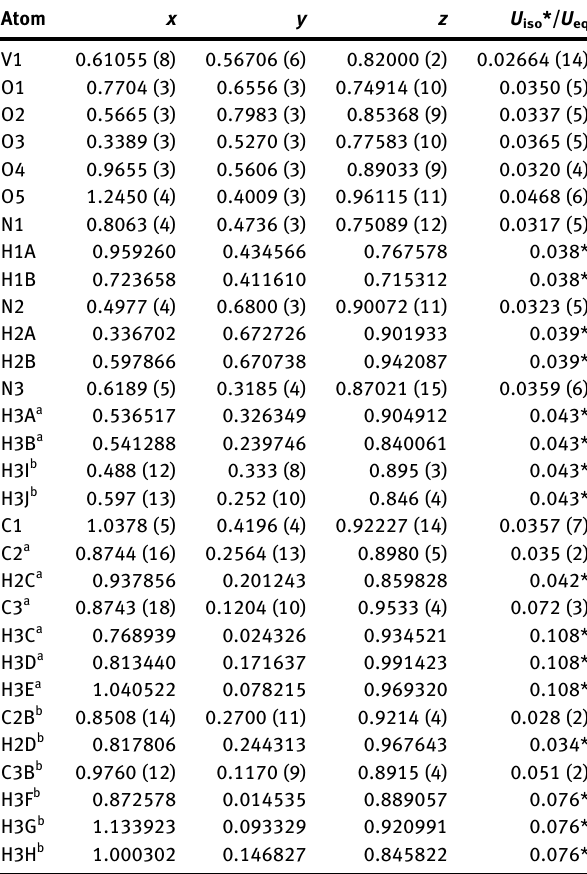
Table  : Fractional atomic coordinates and isotropic or equivalent isotropic displacement parameters (Å  ).